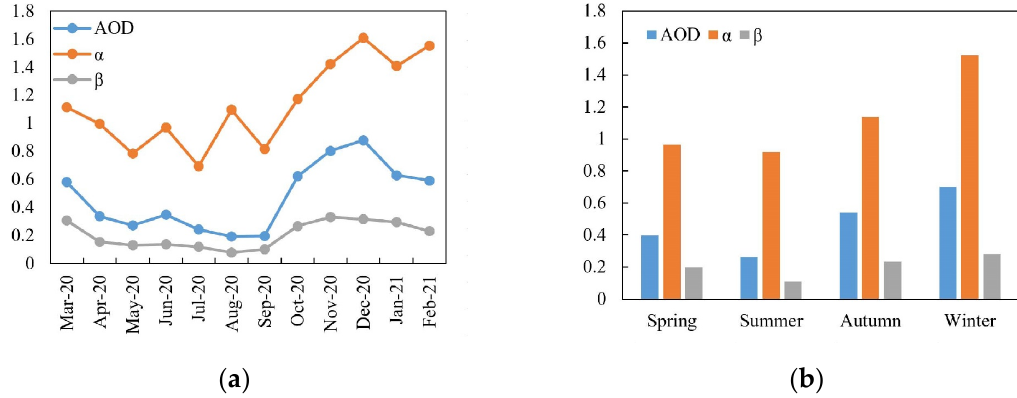
Figure 4. Analysis of variation of AOD, α, and β parameters in Shouxian from March 2020 to February 2021. ( a ) Monthly variation. ( b ) Seasonal variation.